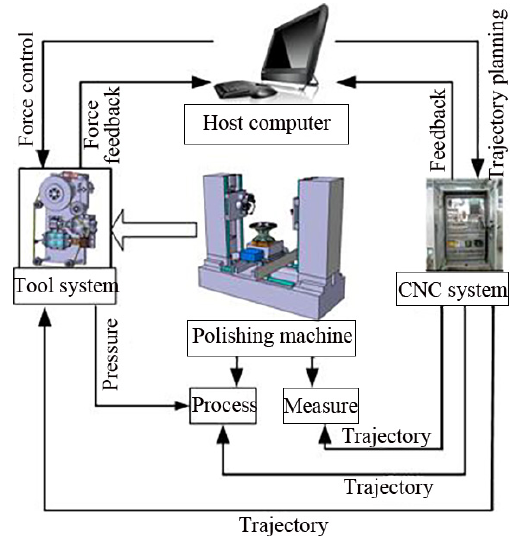
Figure 5. The flow chart of the whole machine.